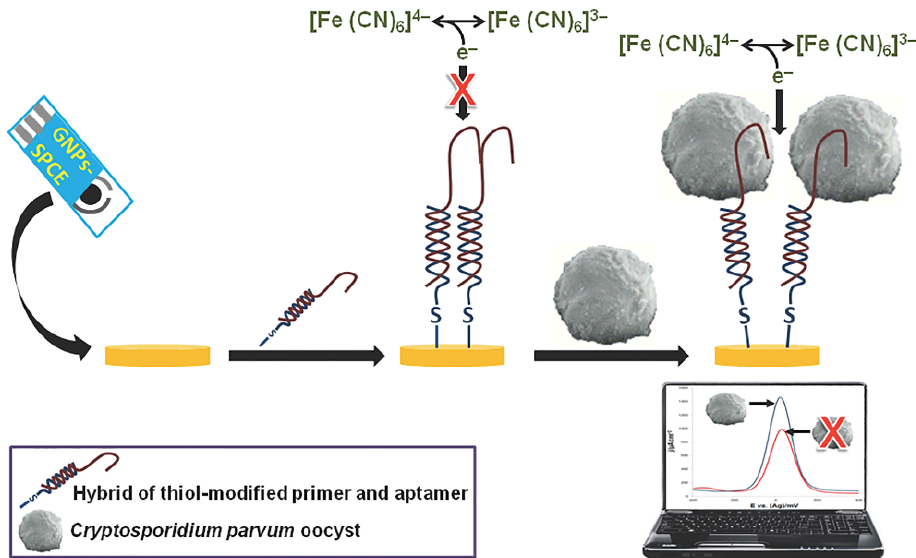
Figure 6. Schematic illustration of the electrochemical detection method used for the detection of Cryptosporidium parvum Oocysts. Self-assembling aptamer and primer hybrids were applied to a carbon electrode that had been screen-printed with gold nanoparticles (GNPs-SPCE). By using square wave voltammetry, the binding of the C. parvum oocyst to the immobilized aptamer increases the redox current. Reprinted with permission from ref. [168]. Copyright 2015, PLOS.